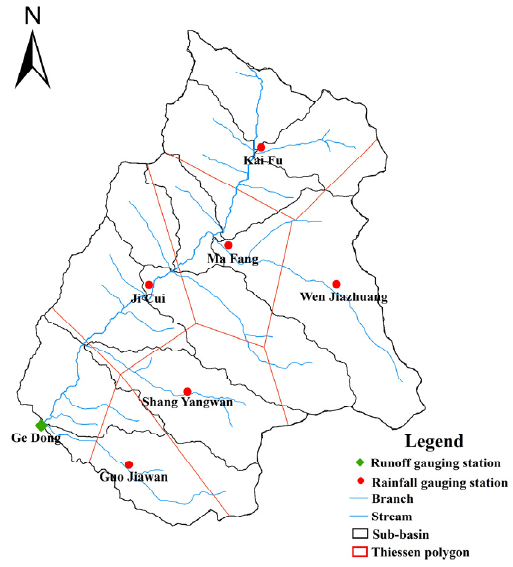
Figure 6. Runoff and rainfall gauging station as well as Thiessen polygon in Gedong basin.